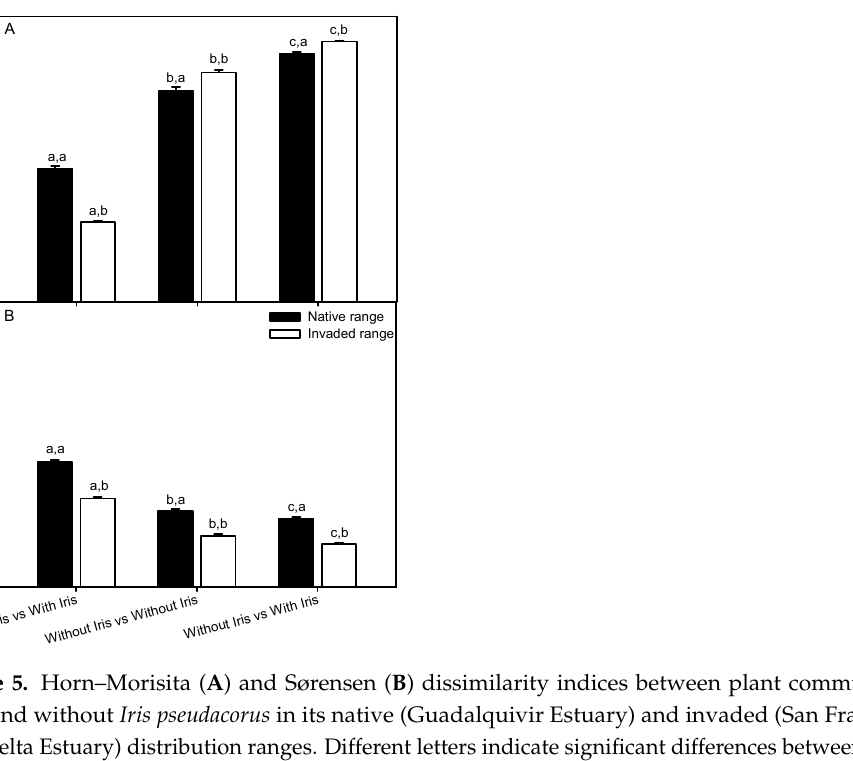
Figure 4. Shannon – Wiener α -diversity (H’) ( A , B ), species richness (S) ( C , D ) and J’ evenness ( E , F ) with and without Iris pseudacorus in its native (Guadalquivir Estuary) and invaded (San Francisco Bay-Delta Estuary) distribution ranges, analyzing both native and exotic species ( A , C , E ) and only native species ( B , D , F ). Different letters indicate significant differences between paired plots with I. pseudacorus presence or absence within each range (first letter) and between ranges (second letter) ( t -test or U-test, p < 0.05). Values are mean ± SE ( n = 38–39).